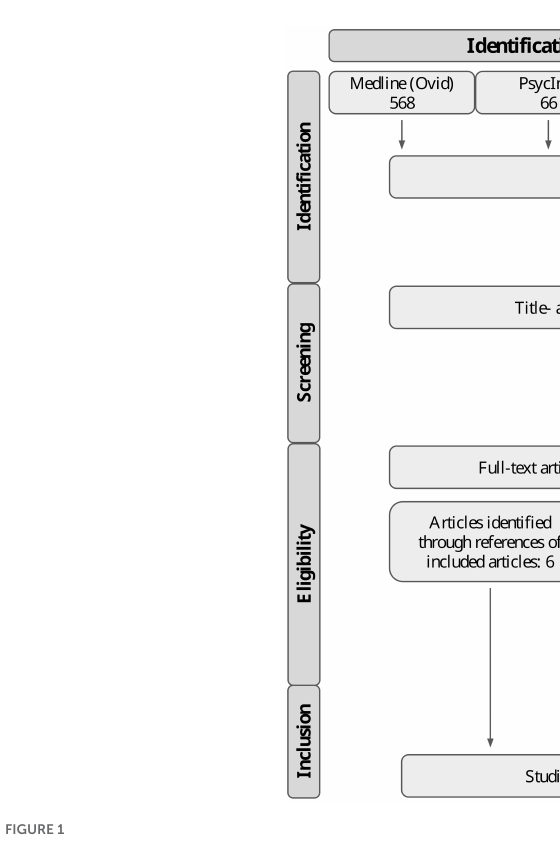
FIGURE1 PRISMA flow